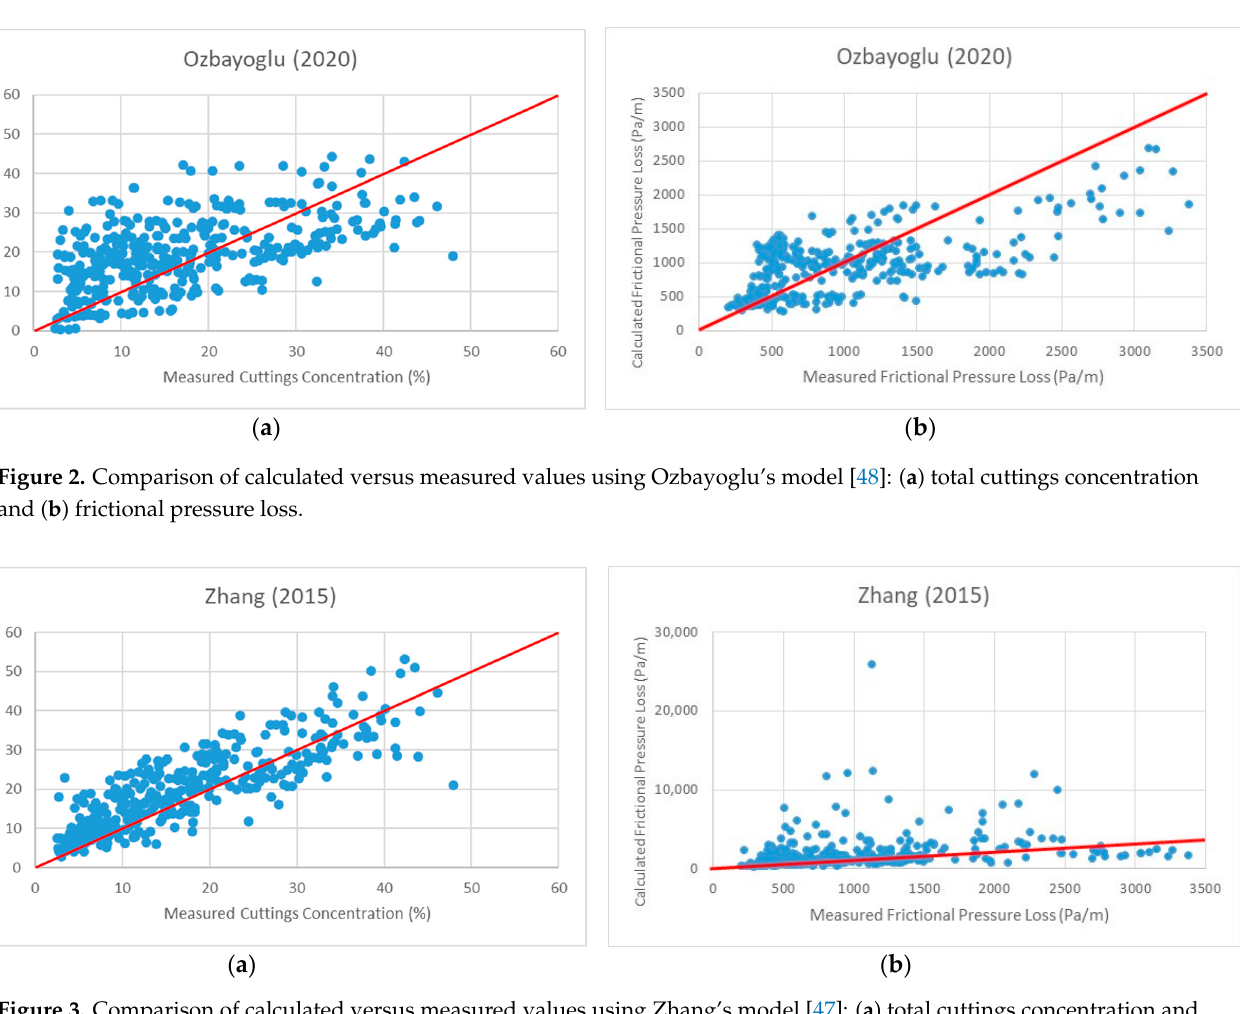
Figure 3. Comparison of calculated versus measured values using Zhang’s model [47]: (a) total cuttings concentration and (b) frictional pressure loss.